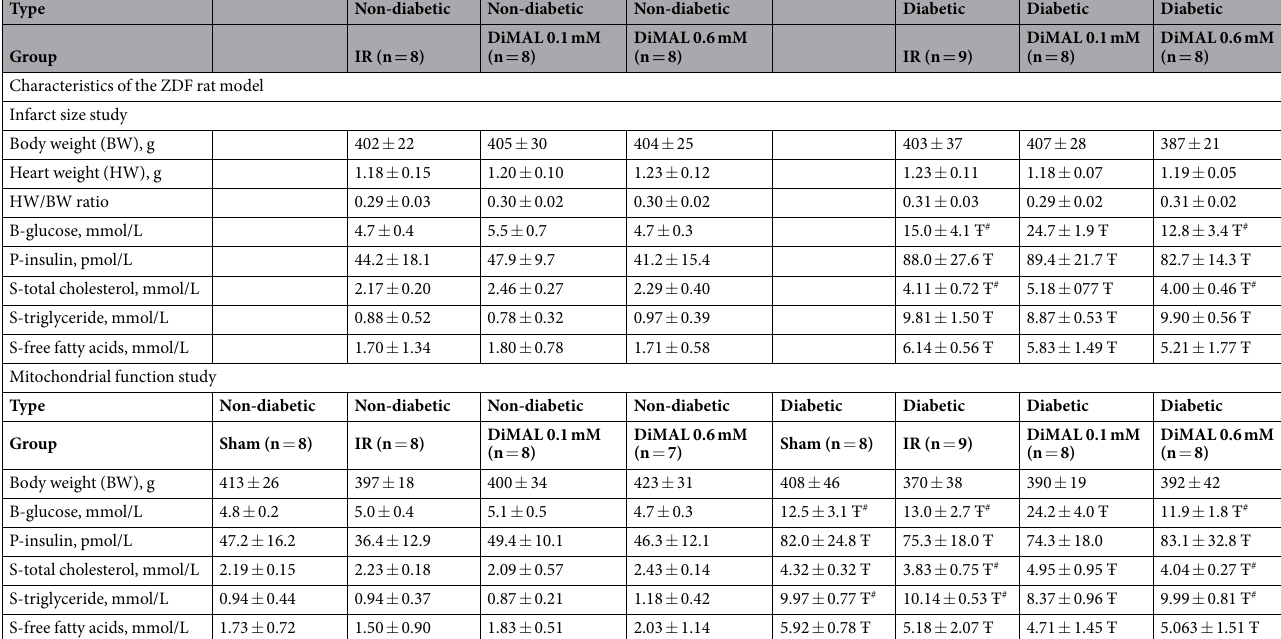
Table 1. Characteristics of the ZDF rat model. Data are mean ± SD. Ŧ P < 0.05 grouped diabetic rats